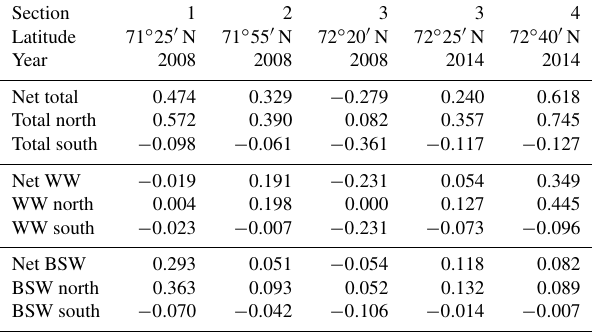
Table 2. Volume transport computed from observations according to section 2.2 for the sections in Herald Canyon. All transport is in Sv (10 6 m 3 s − 1 ). Negative values denote southward transport; positive values denote northward transport. Note that the values for the total volume transport are larger than the sum of the WW and BSW transport due to the presence of other water masses in Herald Canyon (Fig.